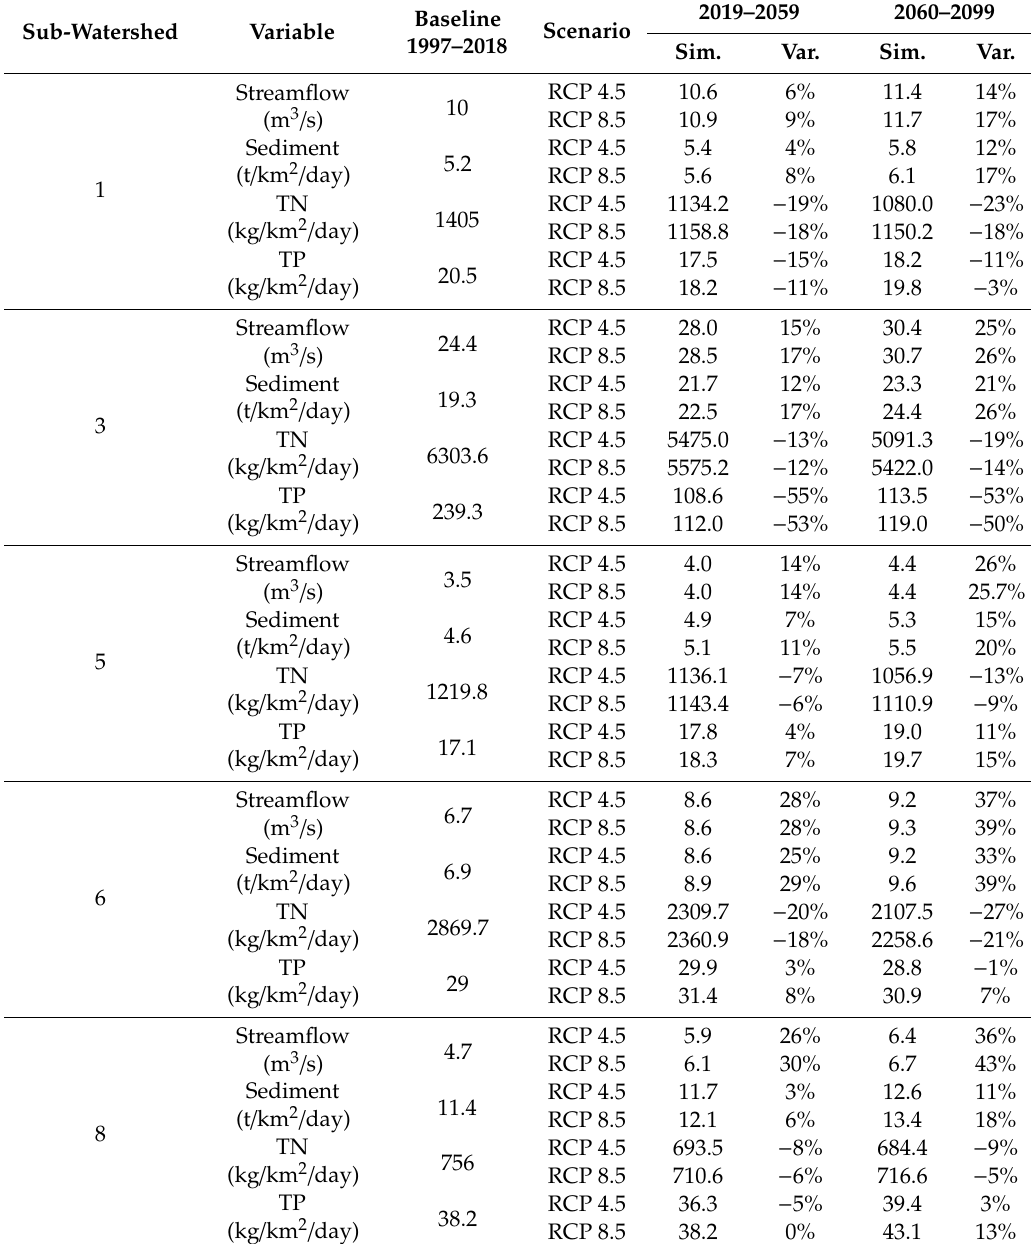
Table 6. Monthly average streamflow, sediment, and total nitrogen (TN) and total phosphorus (TP) loads under two representative concentration pathway (RCP) climate changes